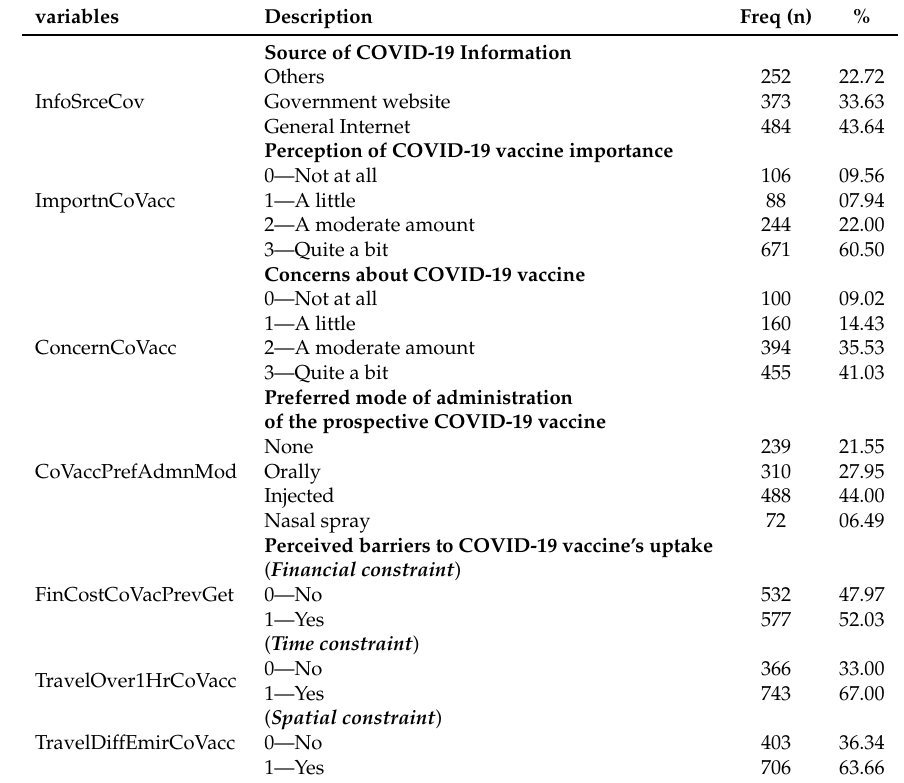
Table A4. Contextual and vaccine specific influences on individual perceived COVID-19 vaccine utility (n =